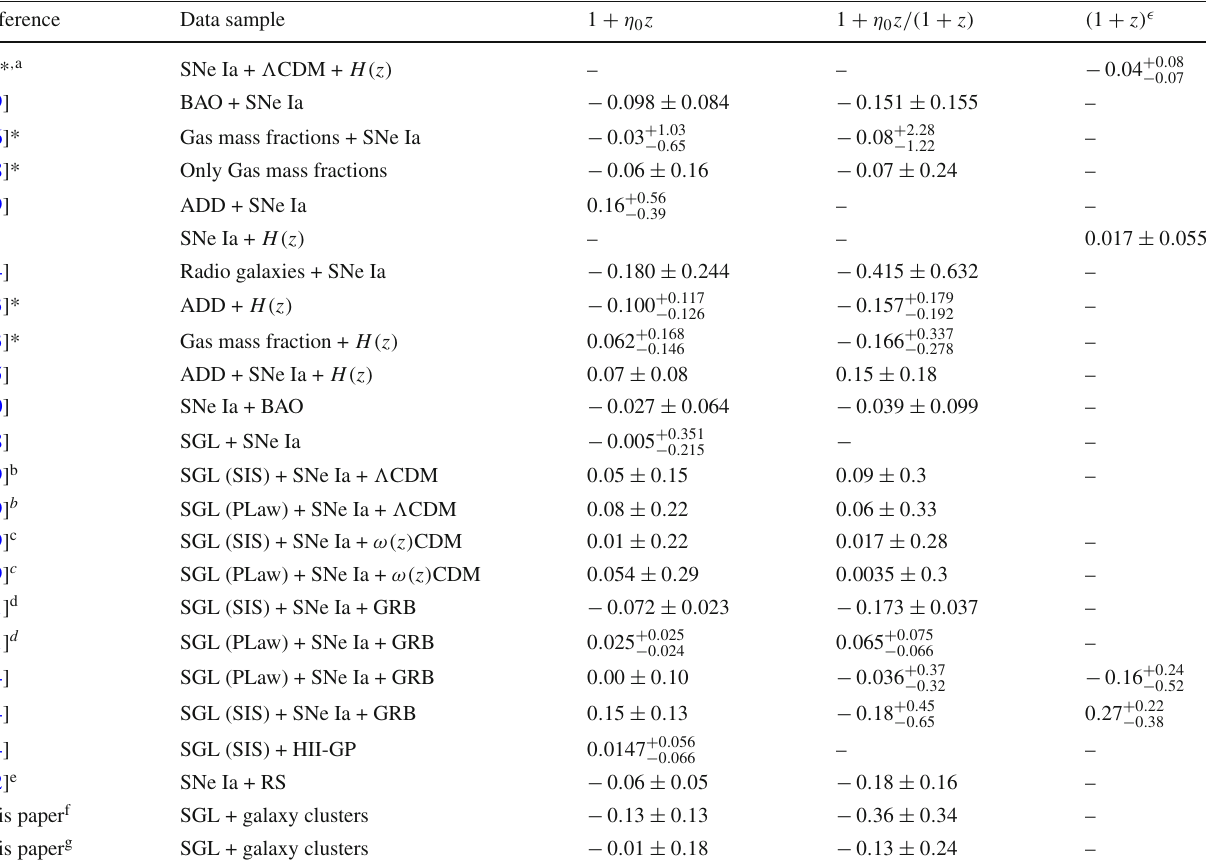
Table 1 A summary of the current constraints on the η 0 and (cid:9) parameters from different